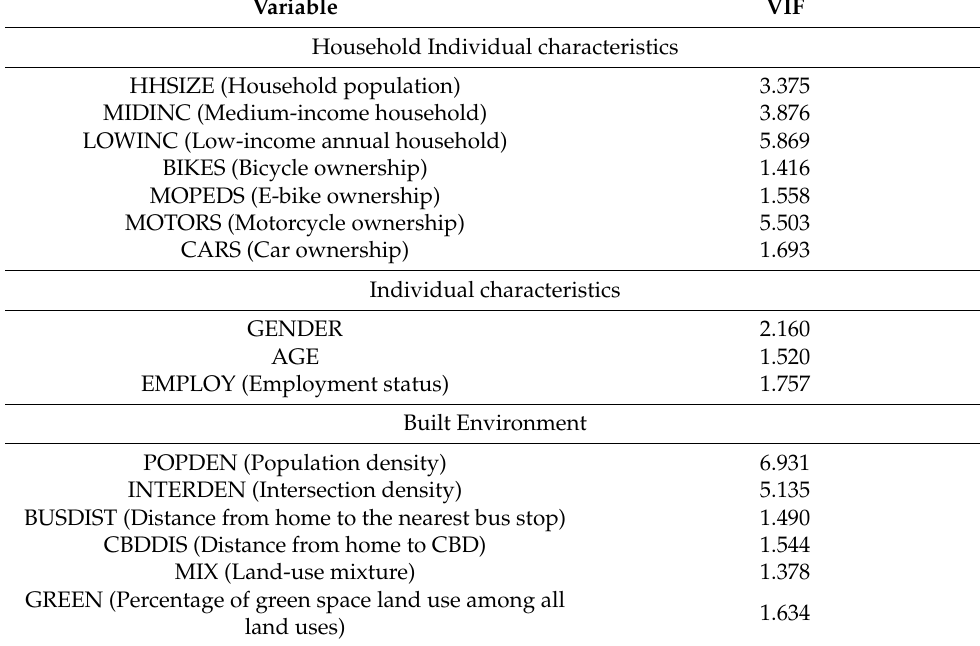
Table 4. The results of VIF